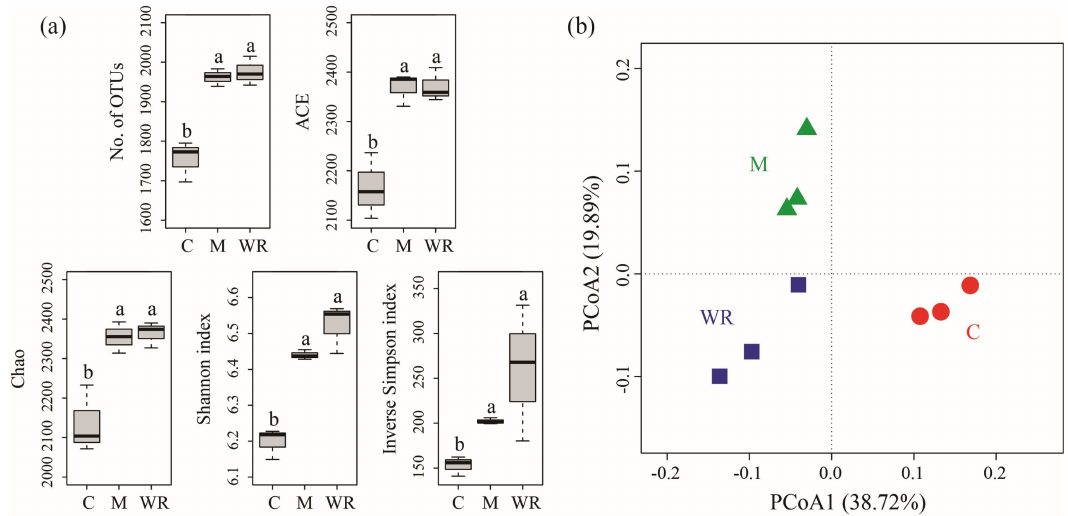
Figure 3. Cucumber rhizosphere bacterial community alpha ( a ) and beta diversities ( b ). C, M and WR represent treatments of cucumber monocropping, rotations with Indian mustard and wild rocket, respectively. Different letters indicate statistically significant differences among treatments (Tukey’s HSD, p <